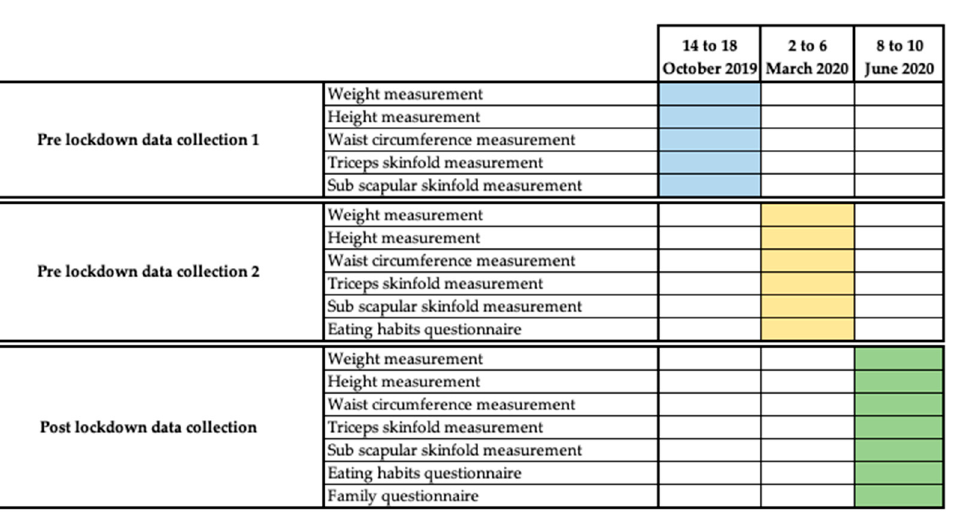
Figure 1. Data-collection schedule. Questionnaires and averages.